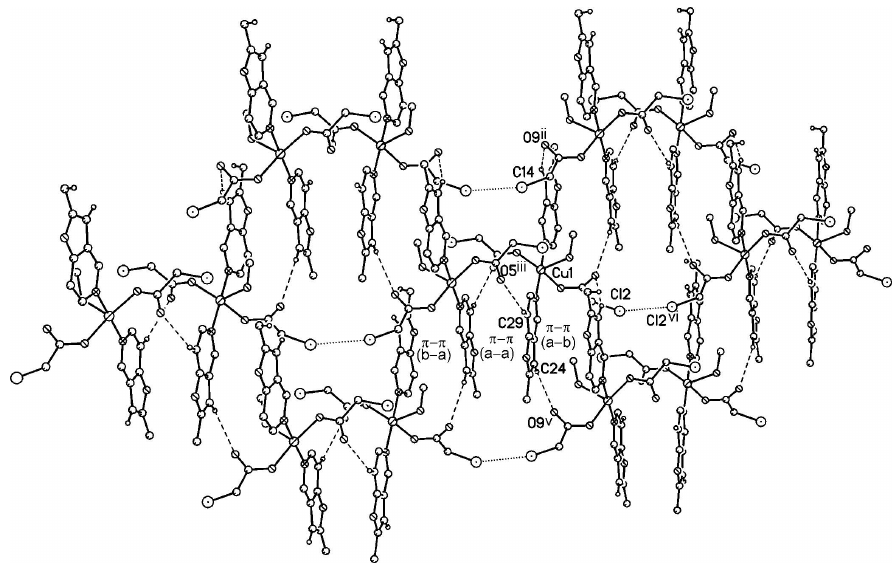
Figure 2 The crystal packing of the title compound with C–H···O hydrogen bonds, Cl···Cl contacts and π - π stacking interactions. Symmetry codes: (ii) - x + 3/2, y - 1/2, - z + 1/2; (iii) - x + 1, y , - z + 1/2; (v) - x + 3/2, y + 1/2, - z + 1/2; (vi) - x + 2, y , - z +